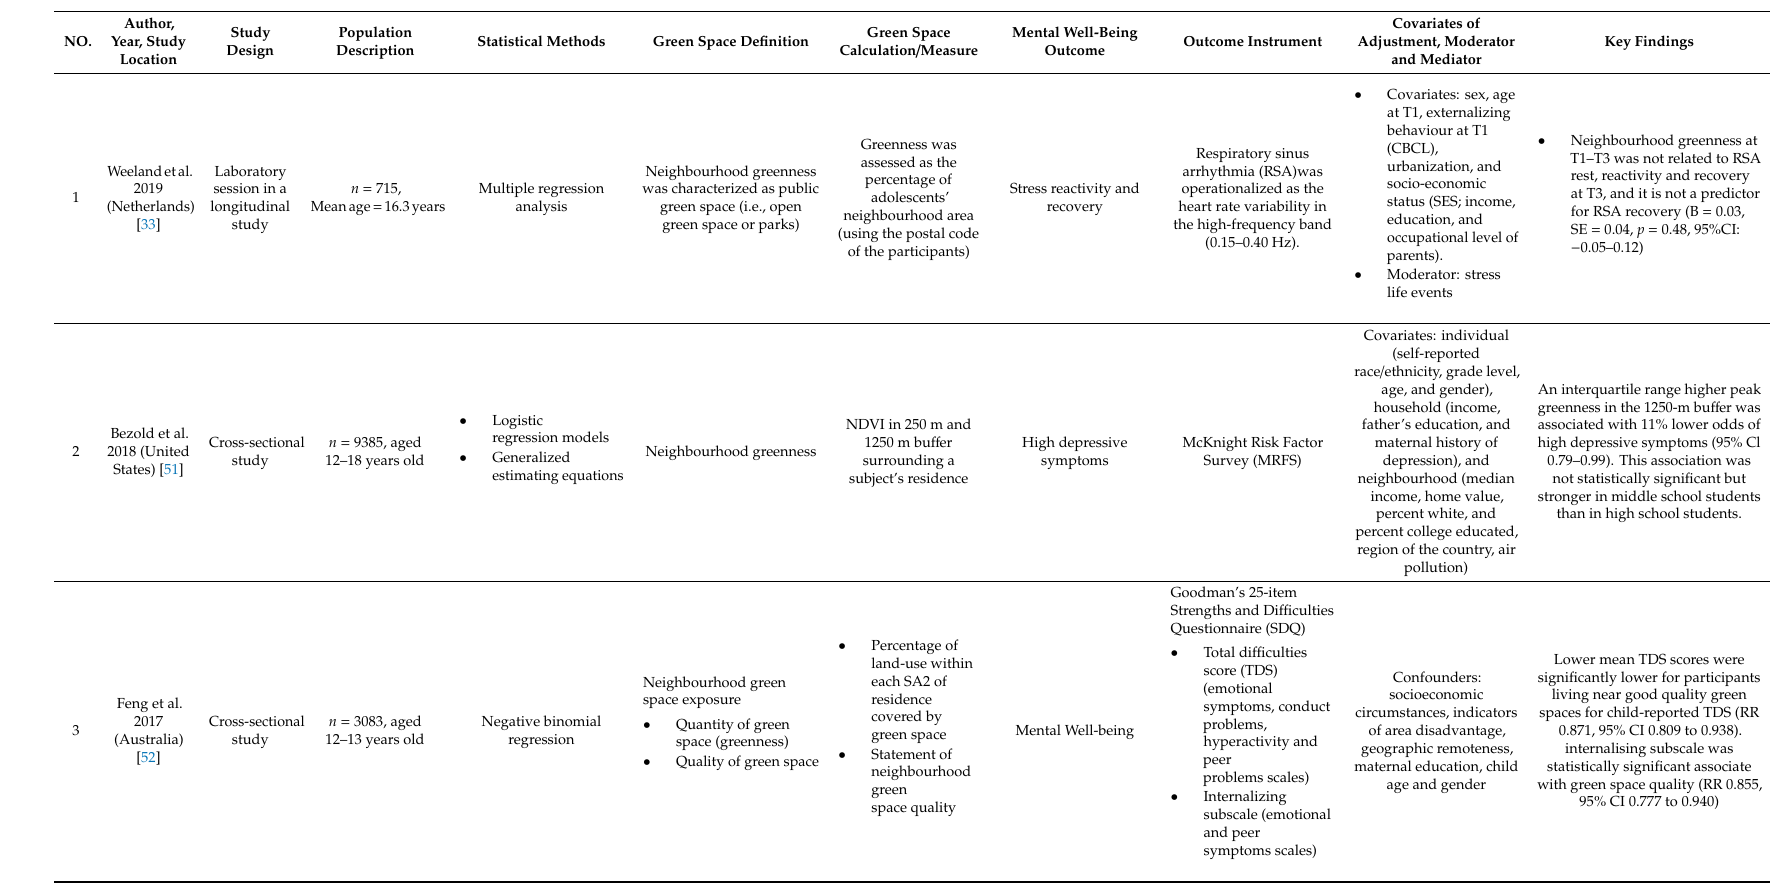
Table 1. Main characteristics and results of the studies on green space and adolescents’ mental